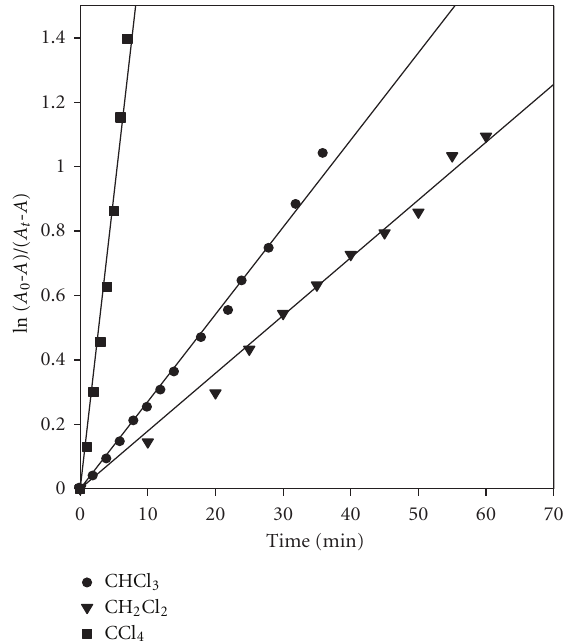
Figure 9: First order plots of photoreactivity of POPOP in chloro- methane